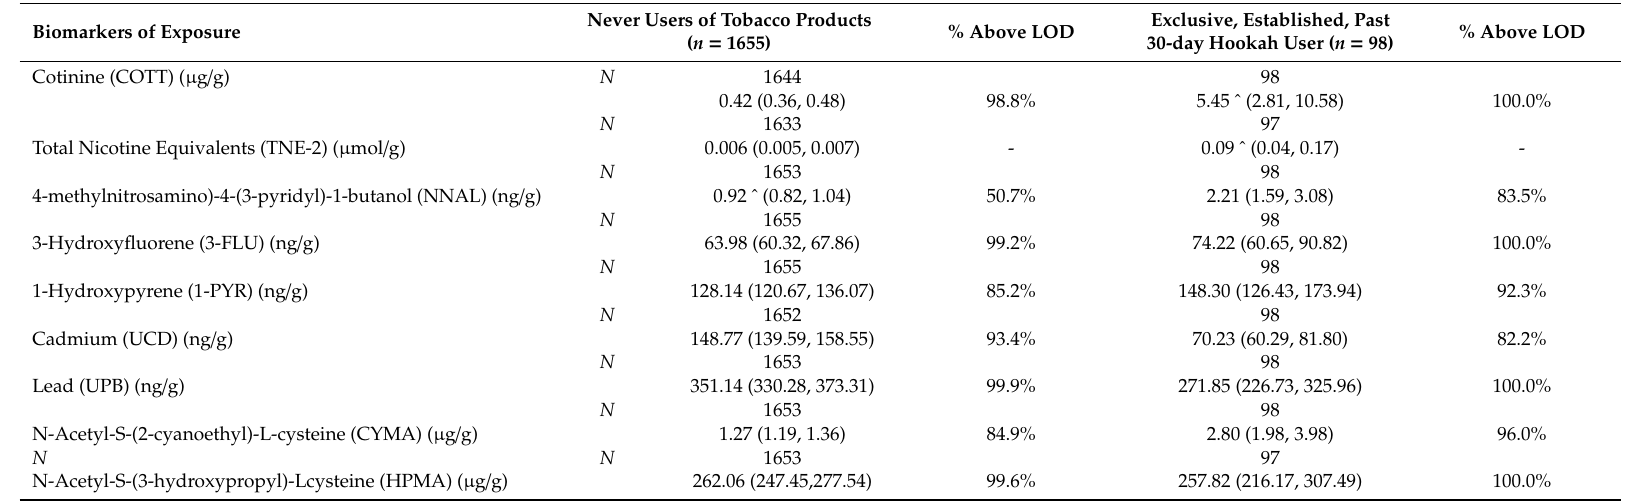
Table 3. Geometric mean urinary biomarker concentrations and 95% CI (creatinine adjusted) by hookah use status. Biomarkers of